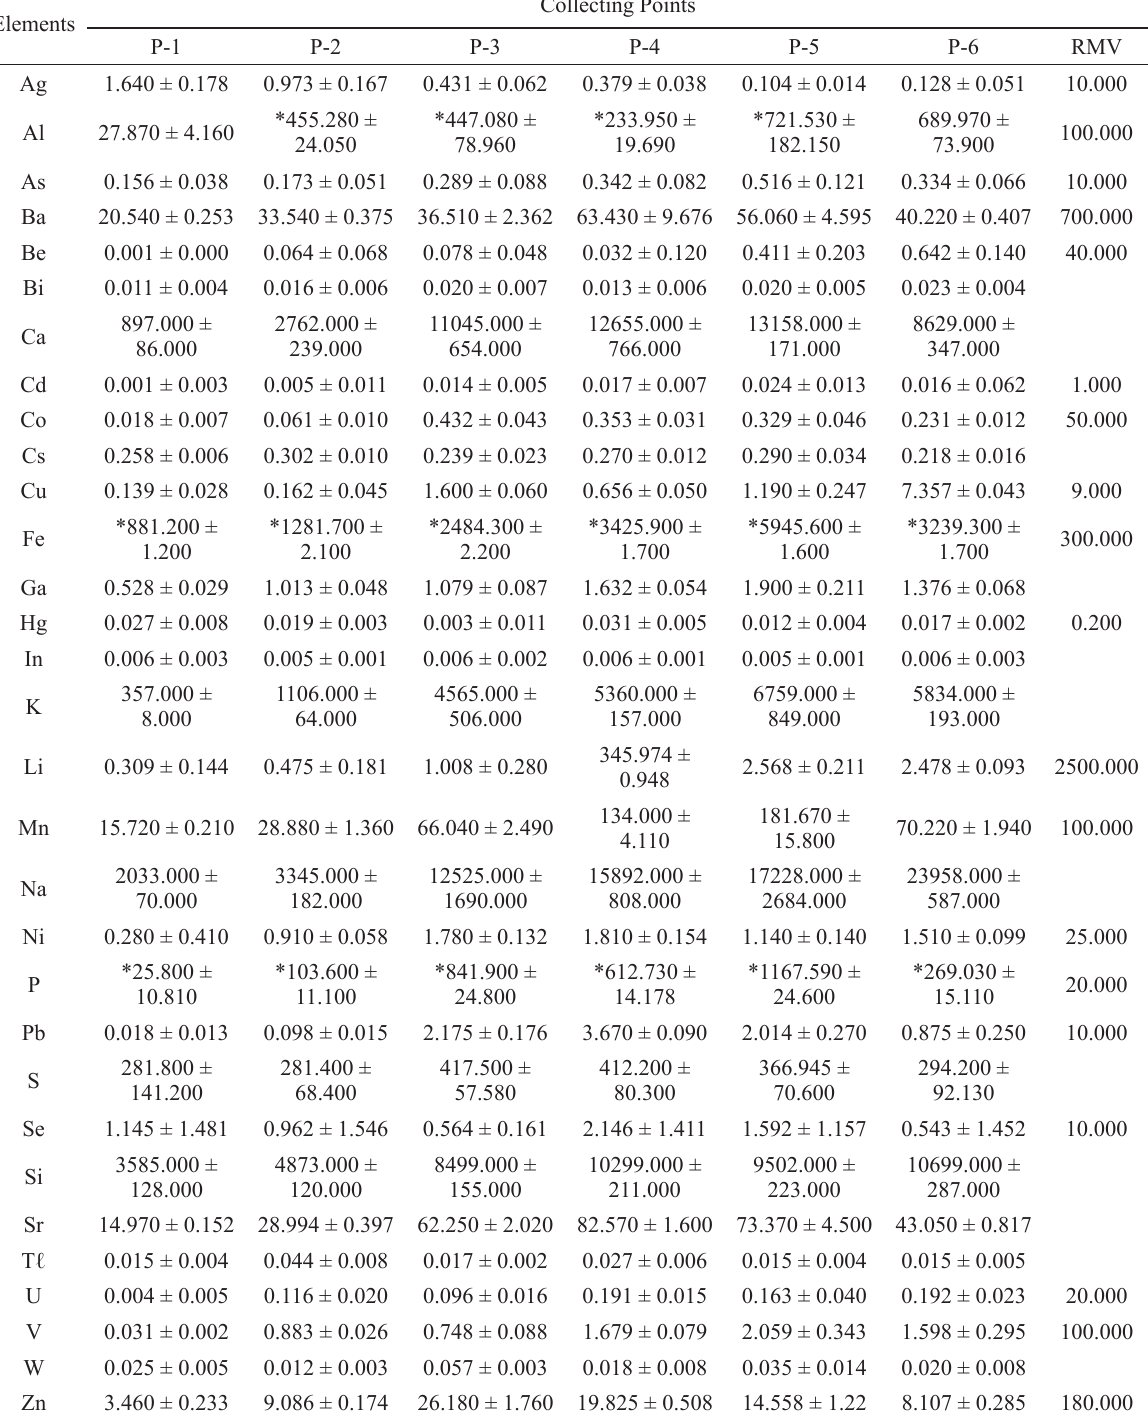
Mean values of trace element concentrations in water samples during the dry season (sample concentration ± standard deviation in µg L -1 ). RMV in µg L -1 (Recommended Maximum values according to CONAMA